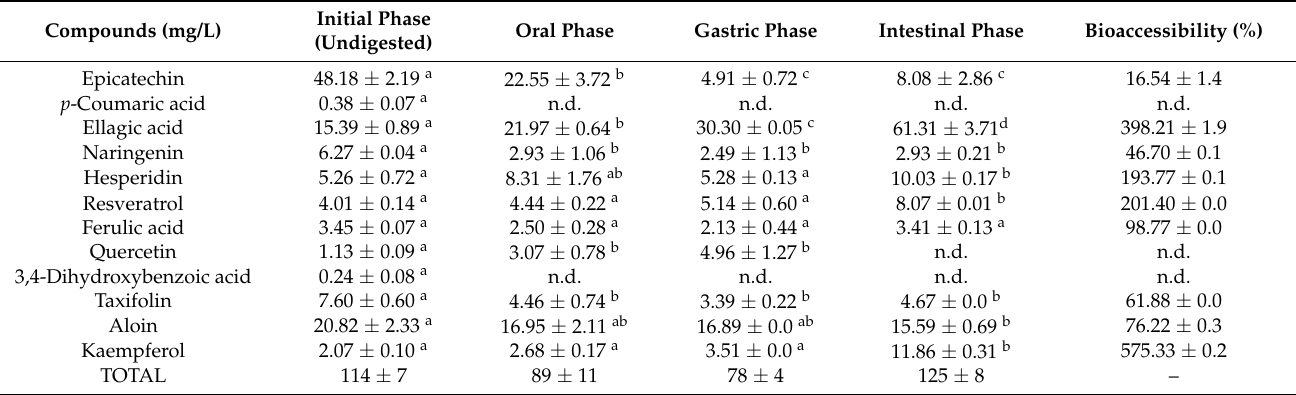
Table 4. Phenolic compounds identification and quantification of undigested and during in vitro digestion of Aloe vera juice fermentation with Lactobacillus lactis ( AvL ). Data given in